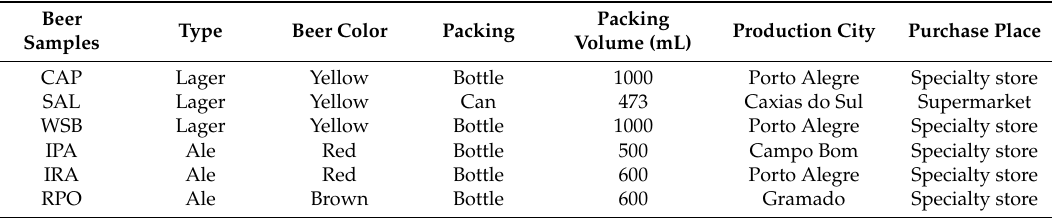
Table 1. Characteristics of each craft beer samples regarding their production and packaging type. Classic American pilsner (CAP), standard American lager (SAL), weissbier (WSB), American India pale ale (IPA), Irish red ale (IRA), and robust porter